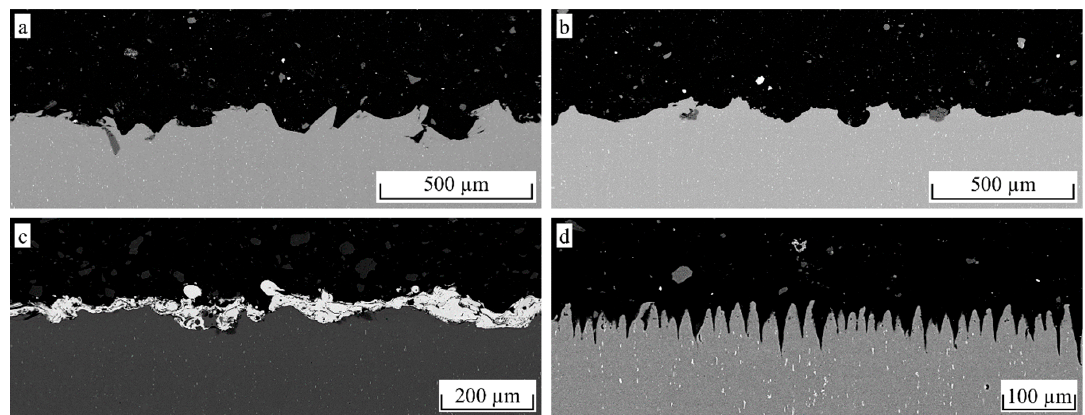
Figure 12. Representative cross-sectional images (SEM) of hollow cylinder specimens, scale normalized to image width/ R z = 1/15 ( a ) F16, 2 bar ( b ) F16, 3 bar + 5 min NaOH ( c ) NiAl5 coating and ( d ) pin structure.